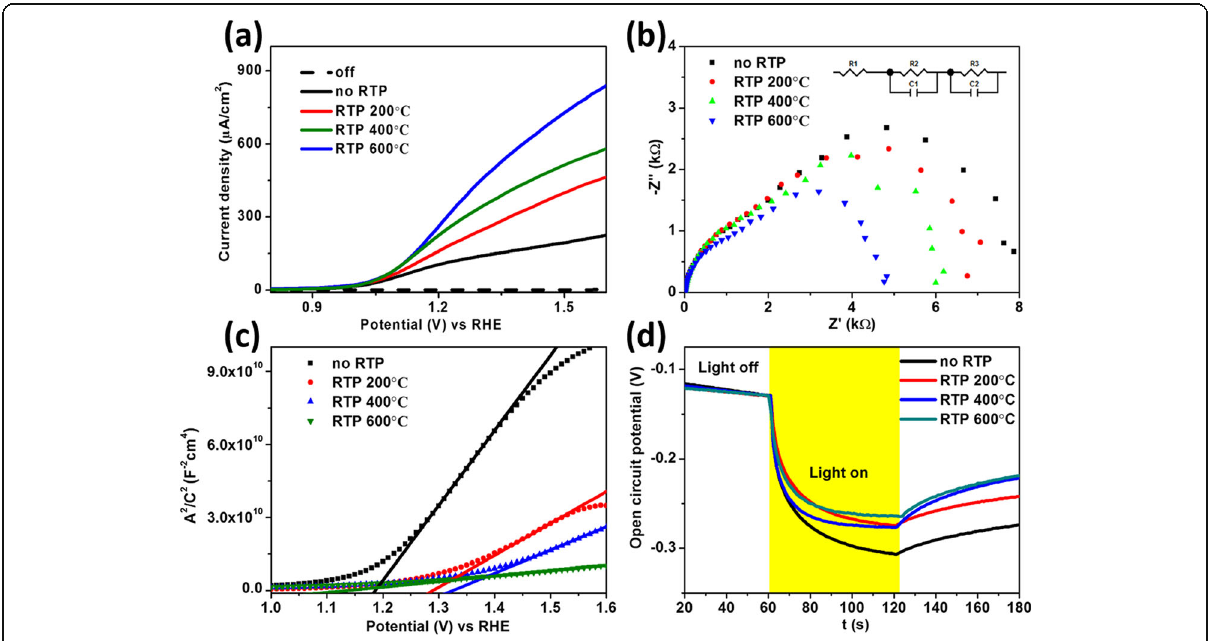
Fig. 4 a J-V curves of the 15% Sn doped hematite photoanode with post-RTP at different temperatures. b , c The corresponding photoelectrochemical impedance spectra and Mott-Schottky plots, respectively. d The change of open circuit potential under the light-on/light-off